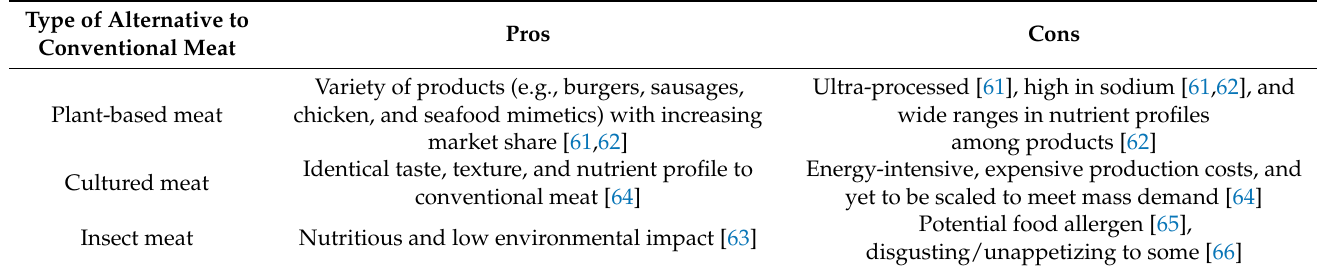
Table 1. Pros and cons of three main types of alternatives to conventional meat. Type of Alternative